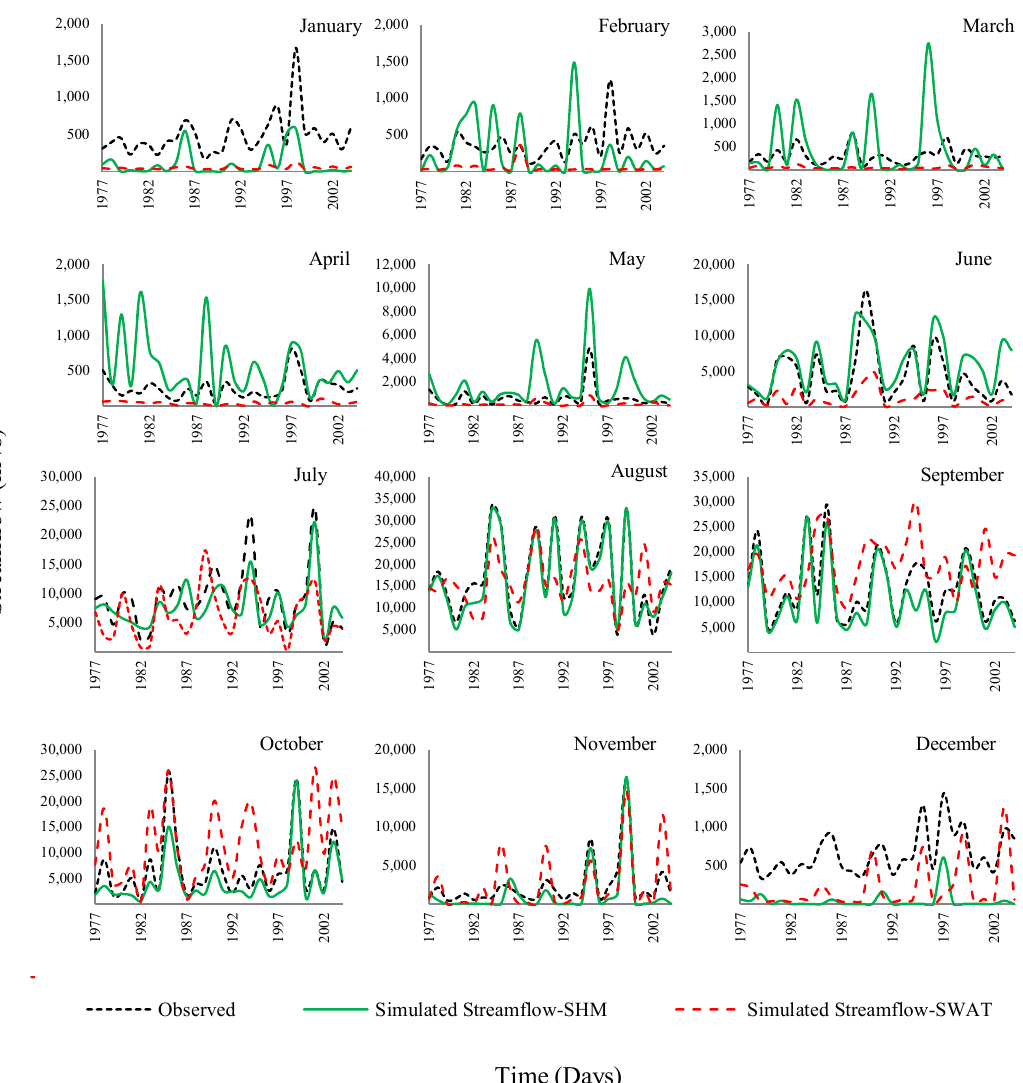
Figure 4. Comparison between observed and simulated monthly streamflow for each month of the year over the total period (calibration and validation) of analysis.